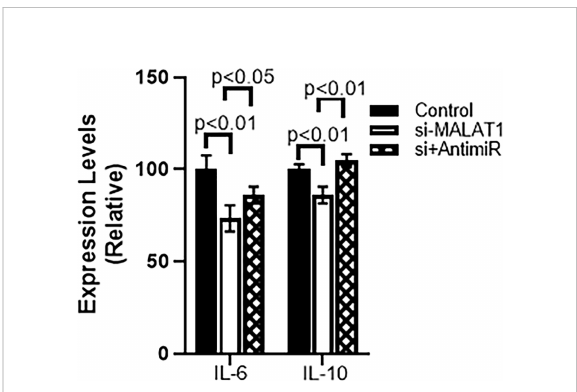
FIGURE 7 miR-124 reverses MALAT1-silencing effects on IL-6 and IL-10 in HH cells. si+AntimiR: